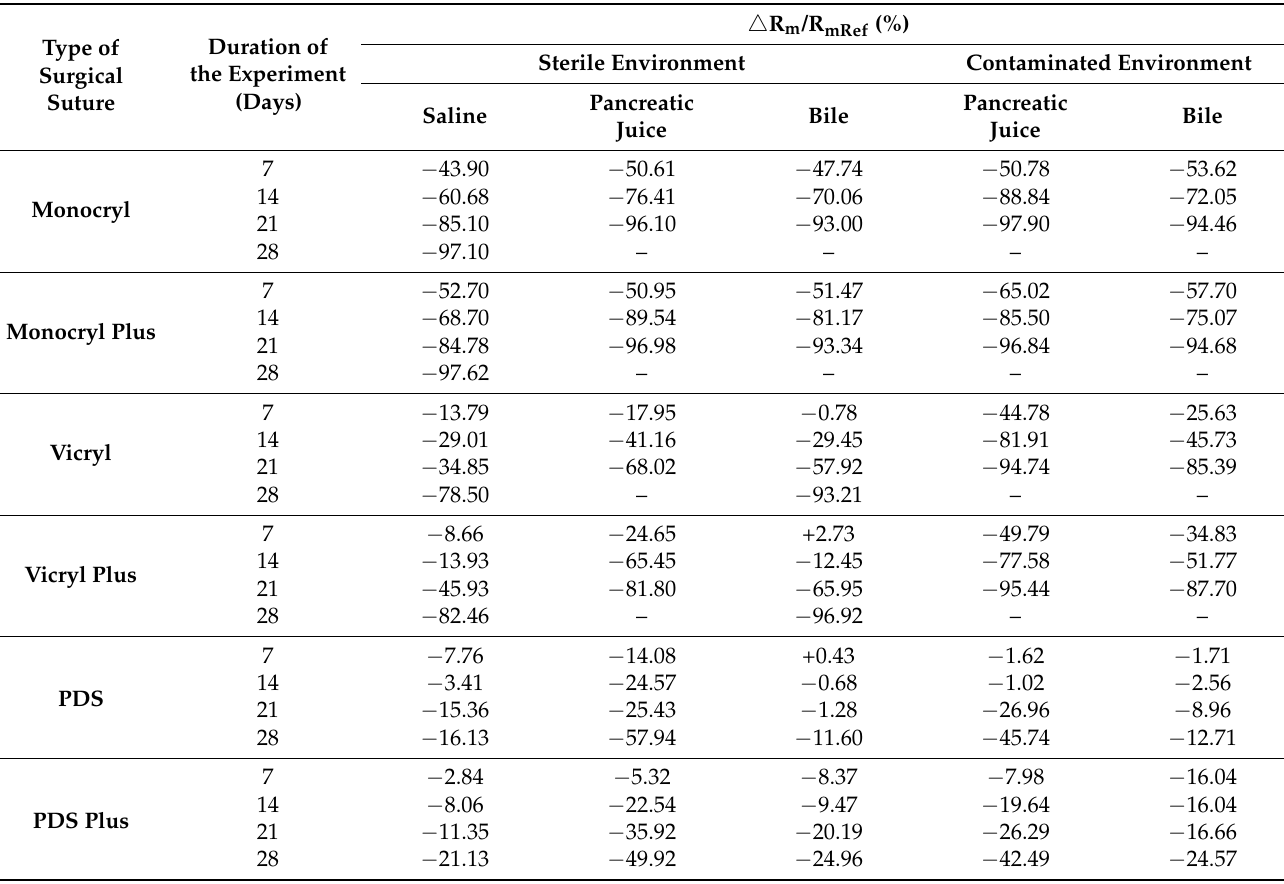
Table 2. Changes in the tensile strength with respect to the tensile strength for the initial surgical